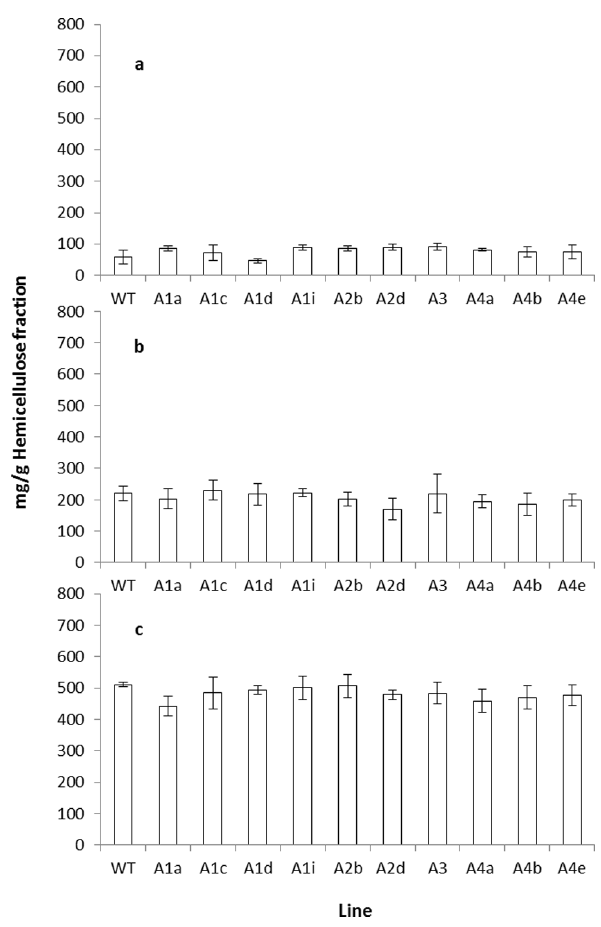
Figure 5. Sugar composition of the hemicellulose rich fraction of wild type and rabA knockout lines. The hemicellulose rich fraction was subjected to hydrolysis and monomer sugar composition in terms of (A) Galactose, (B) Glucose and (C) Xylose assessed by HPAEC. Statistical values are as follows; glucose p=0.0494 (d.f,32 v.r,0.97); xylose p=0.362 (d.f,32 v.r,1.17); galactose p=0.022 (d.f,32 v.r,2.7).